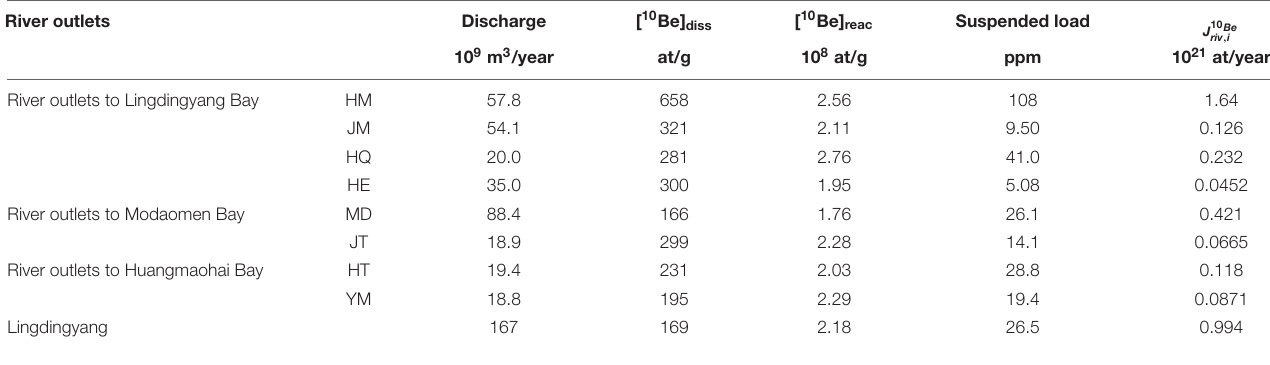
in crystalline oxides are also included. Thus, the equation (5) is transformed as sum of eight outlets to equation